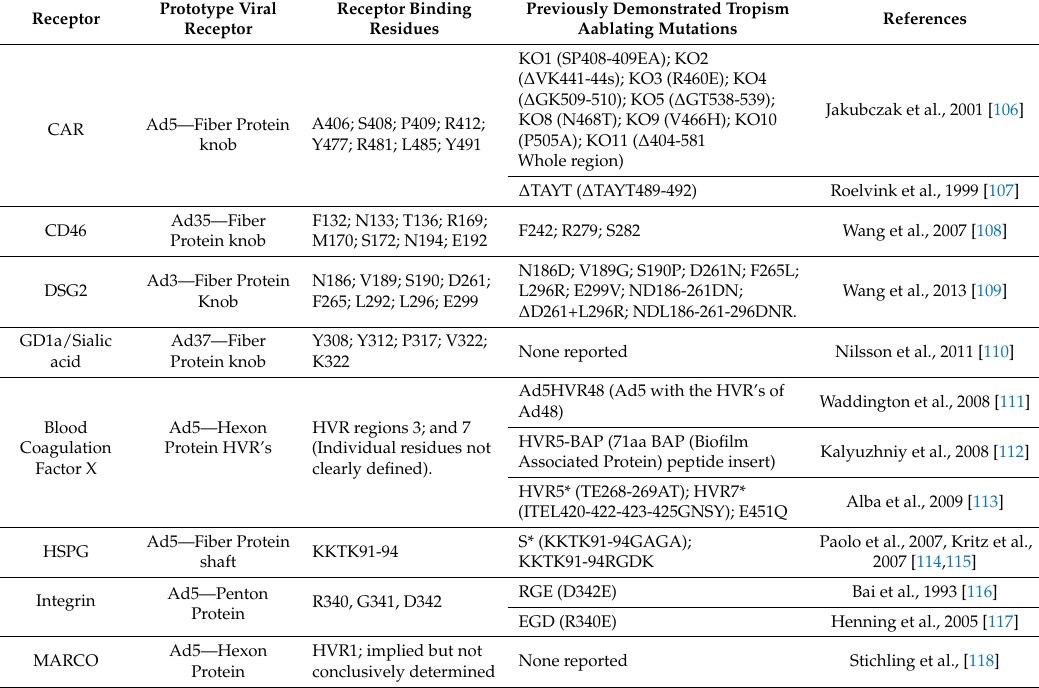
Table 1. Adenovirus receptor, the residues shown to facilitate receptor interactions, and demonstrated tropism ablating mutations. Prototype viral receptor refers to the adenoviral serotype and protein used in the receptor interaction study for which the binding residues and mutations are described. Named mutations are in bold with the mutations in brackets. amino acids are described with single letter code. ∆ indicates a deletion mutation, while substitution mutations are described with the original residue letter codes preceding the residue numbers and then the respective substituted amino acid